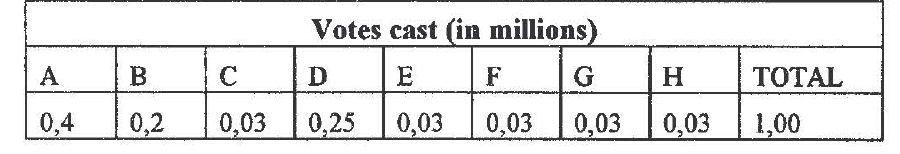
Table 5: A special